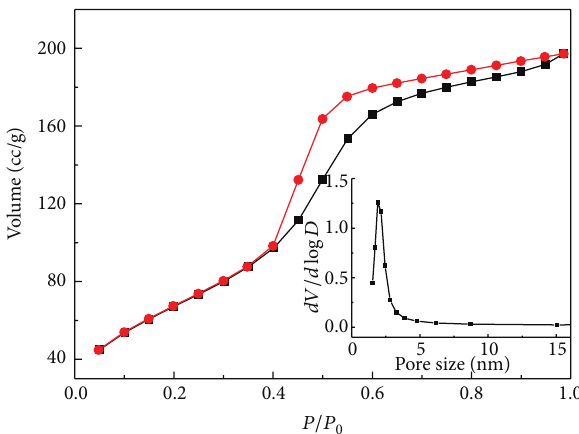
Figure 3: Nitrogen adsorption-desorption isotherm and pore size distribution curves of BG-La-2.